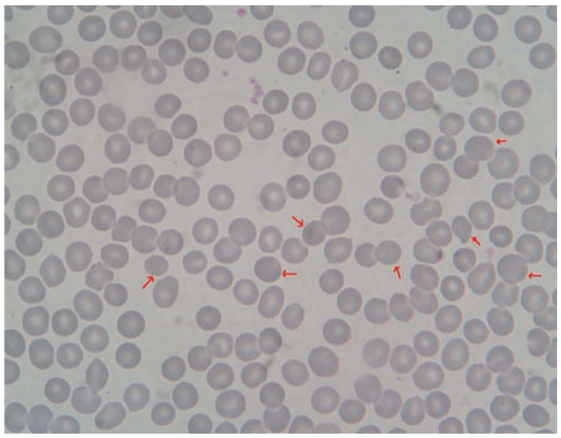
Spherocytes(arrows).